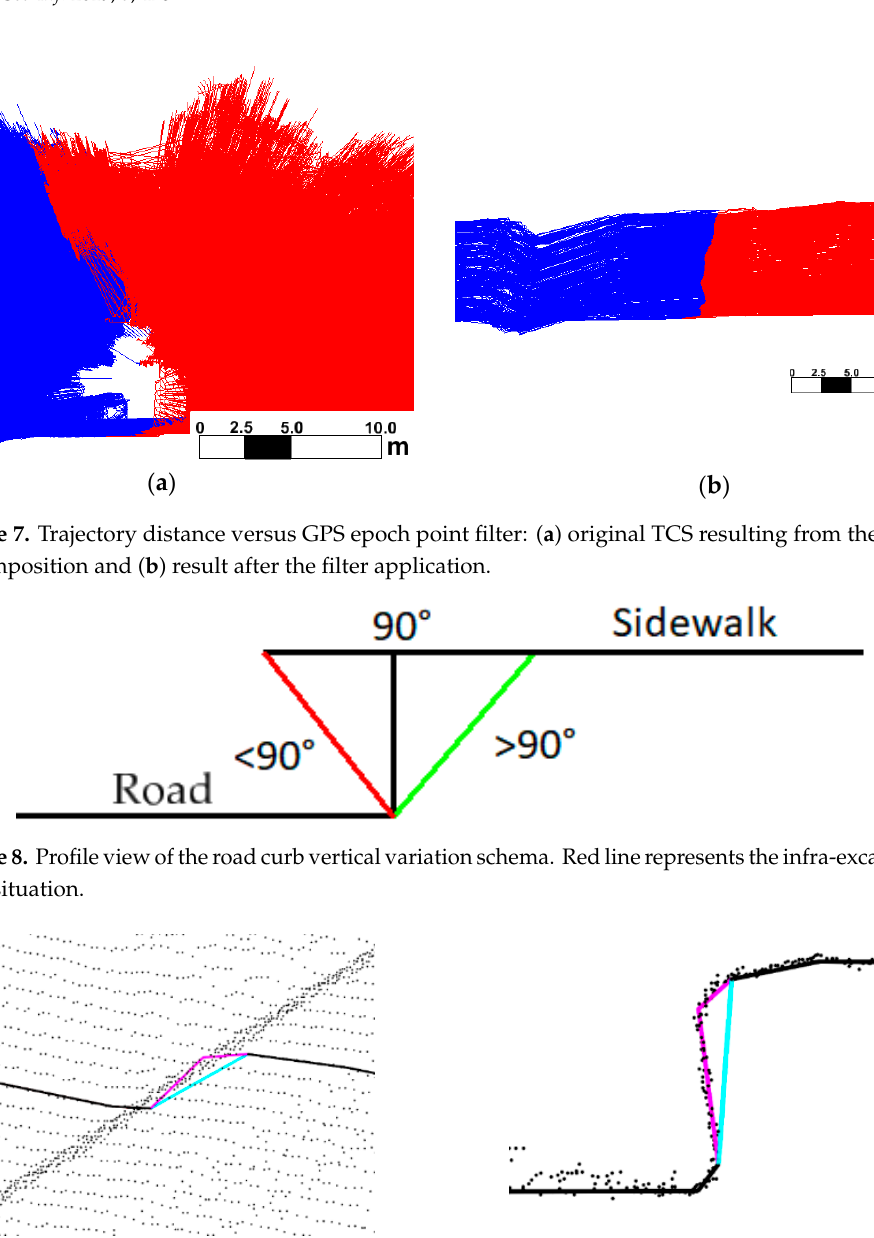
Figure 9. Infra-excavation curb sample using the original TCS (purple) and filter (blue) results: ( a ) curb top view and ( b ) curb profile